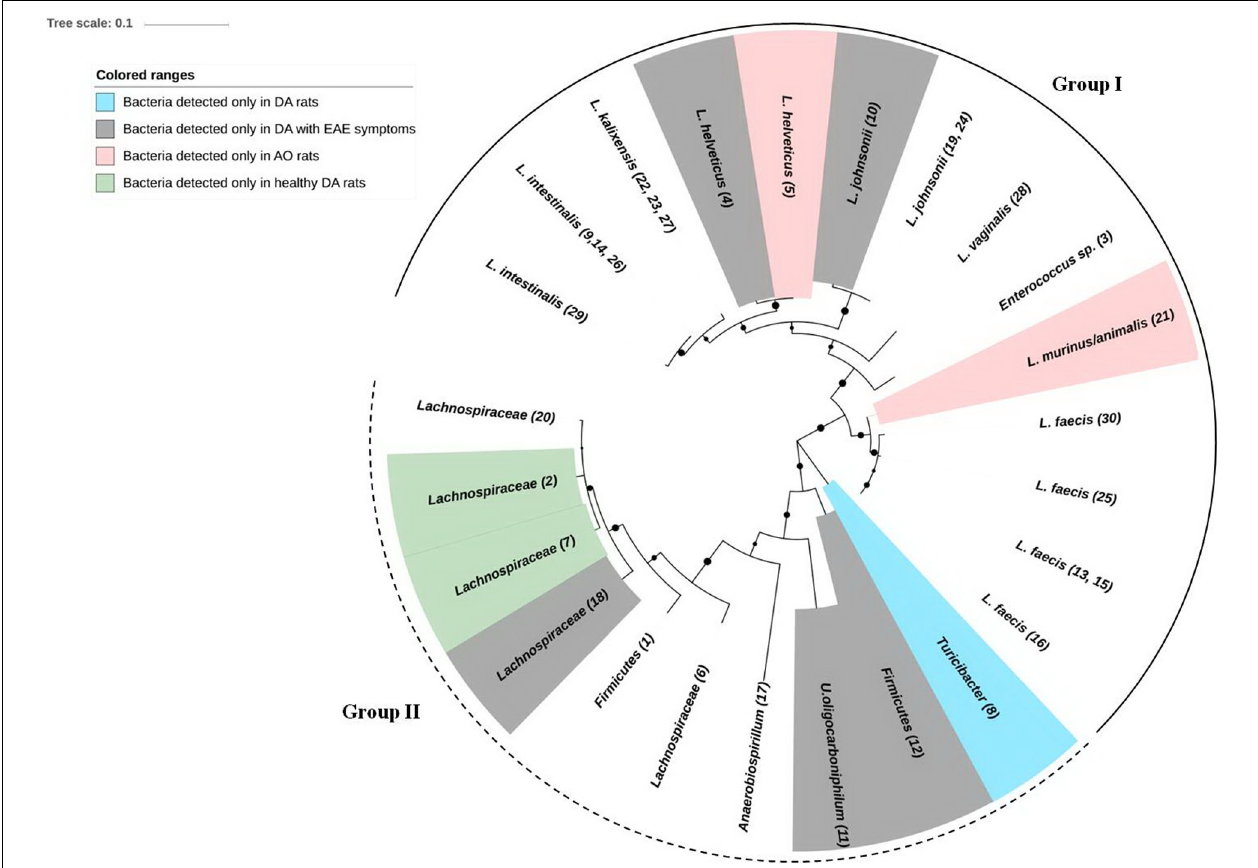
FIGURE 3 | Phylogenetic inferences of 16S rRNA gene among bacteria isolated from DA and AO feces samples. A phylogenetic tree of 16S rRNA genes was constructed with the maximum likelihood (ML) method using a Tamura–Nei model distance matrix. The confidence levels were calculated from 1000 bootstrap resamples of alignment used for phylogenetic inferences by ML method. Black circles represent the nodes with a support bootstrap value of ≥ 40%. Numbers in brackets represent the number of corresponding excised, cloned, and sequenced DGGE band. Group I, including phylum Firmicutes and bacteria from the families Lactobacillaceae , Enterococcaceae , and Turicibacteraceae is denoted by full semicircular line. Group II consisting of bacteria belonging to phylum Firmicutes and Proteobacteria including families Lachnospiraceae , Oxalobacteraceae , and Succinivibrionaceae is denoted by dashed semicircular